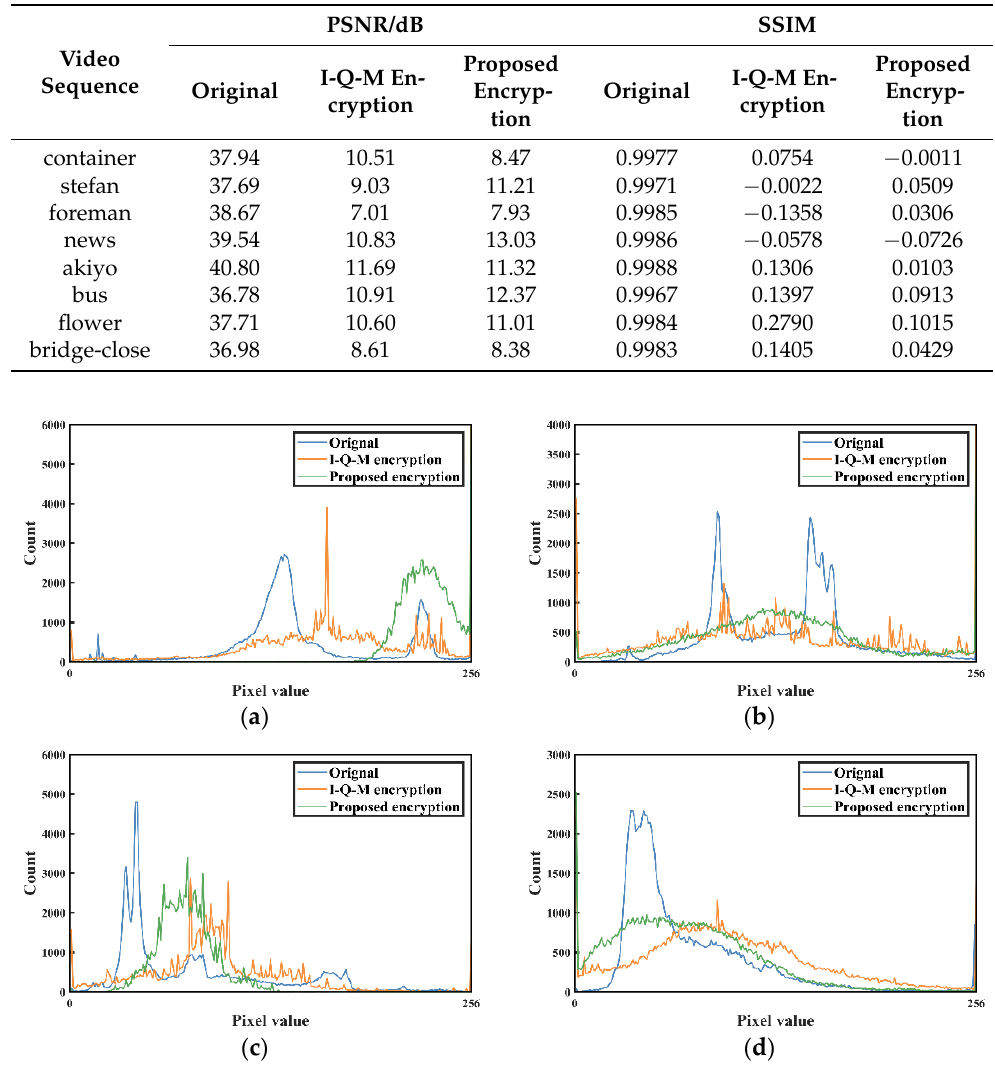
Figure 9. Video frame histogram. ( a ) Container, ( b ) Stefan, ( c ) news, ( d )